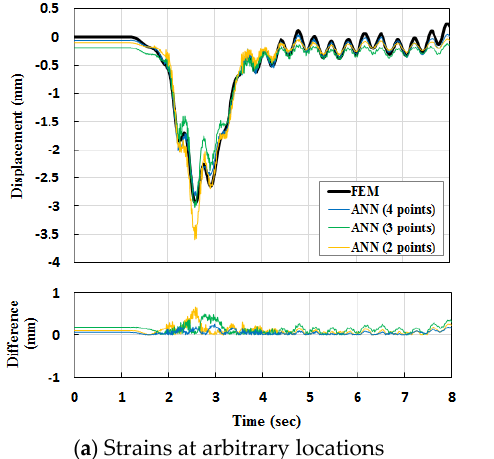
Figure 17. Displacements over time at center girder for 80 km/h test dataset.